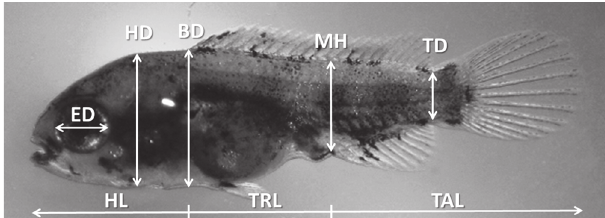
annomala . BD, body depth; ED, eye diameter; HD, head depth; HL, head length; MH, musculature height; TAL, tail length; TD, tail depth; TL, total length and TRL, trunk